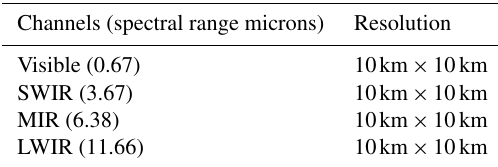
Table 1. Sounder